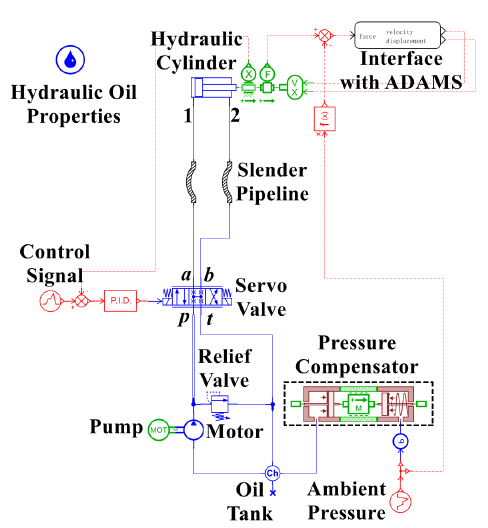
Figure 5. AME Sim model of hydraulic system.